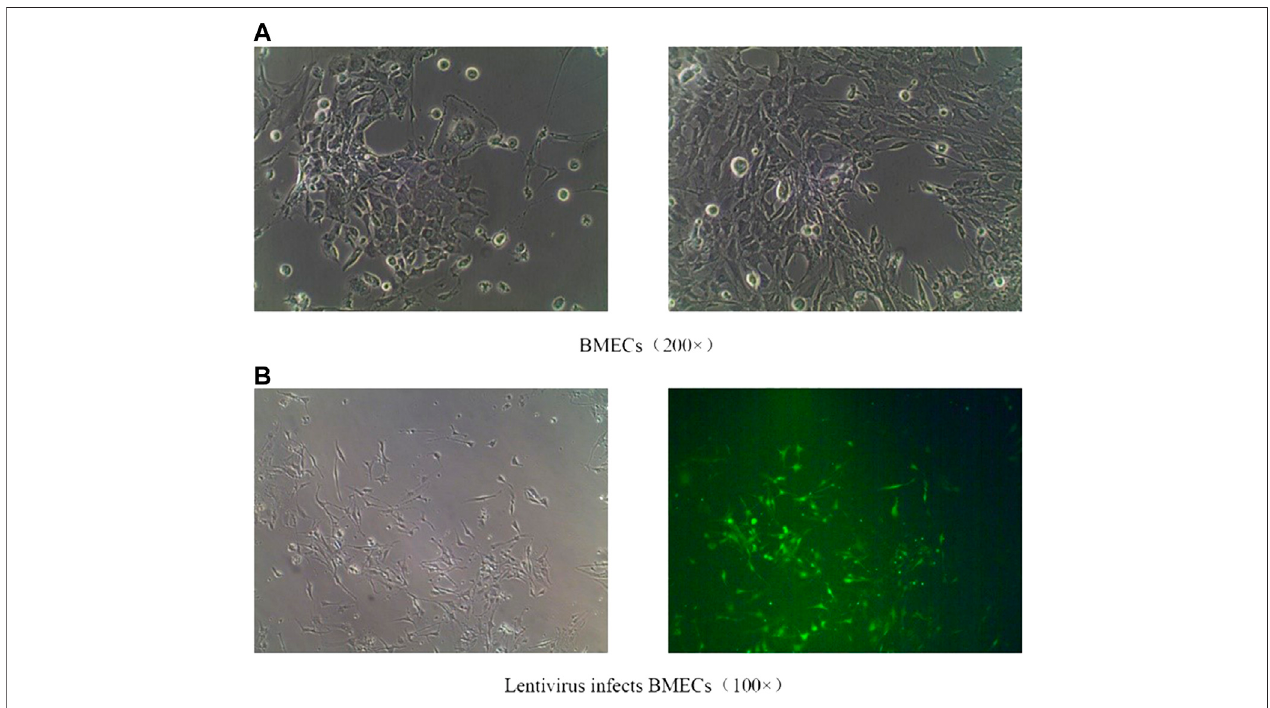
FIGURE 9 | (A) : Normal BMECs; (B) : Effective transfection of BMECs with